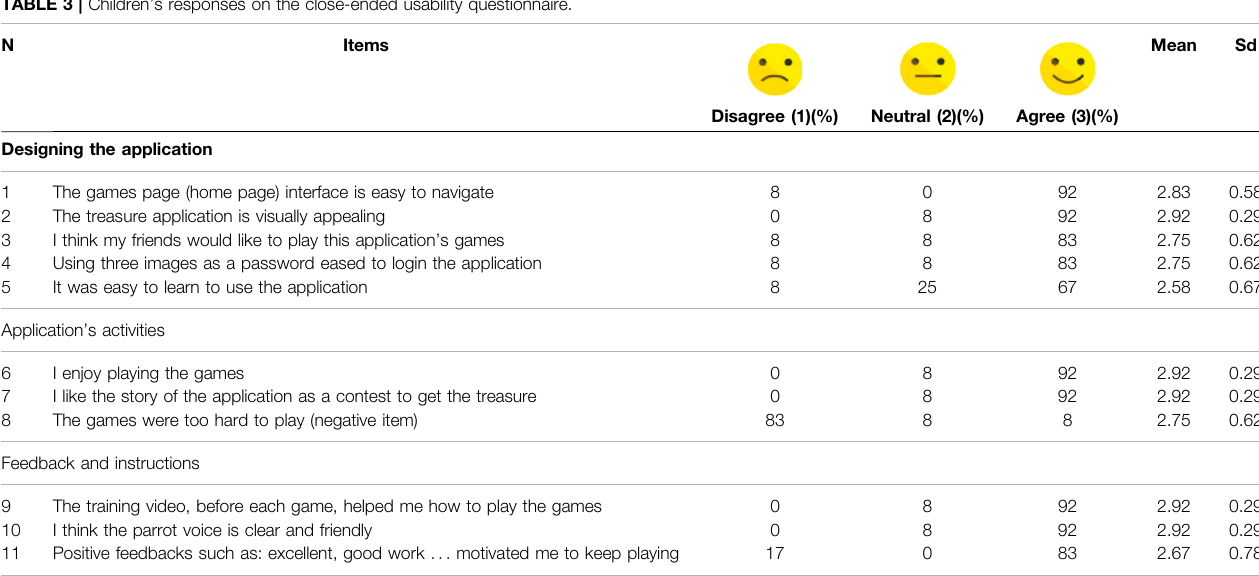
TABLE 3 | Children ’ s responses on the close-ended usability questionnaire. N Items